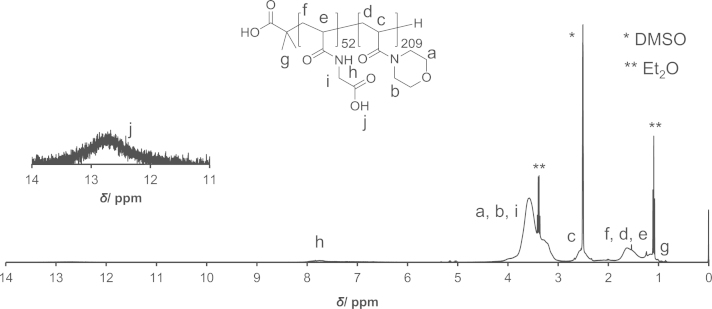
1H NMR spectrum of polymer (7).